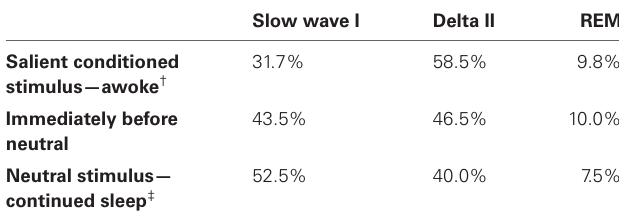
Table 1 | Arousal or continued sleep in response to acoustic stimuli by sleep architecture